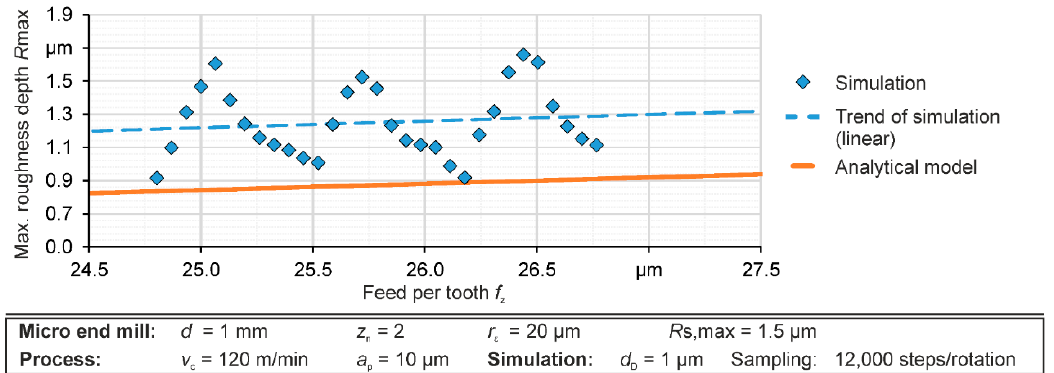
Figure 16. Influence of the back cut on the maximum roughness depth with variation of the tooth feed rate. feed